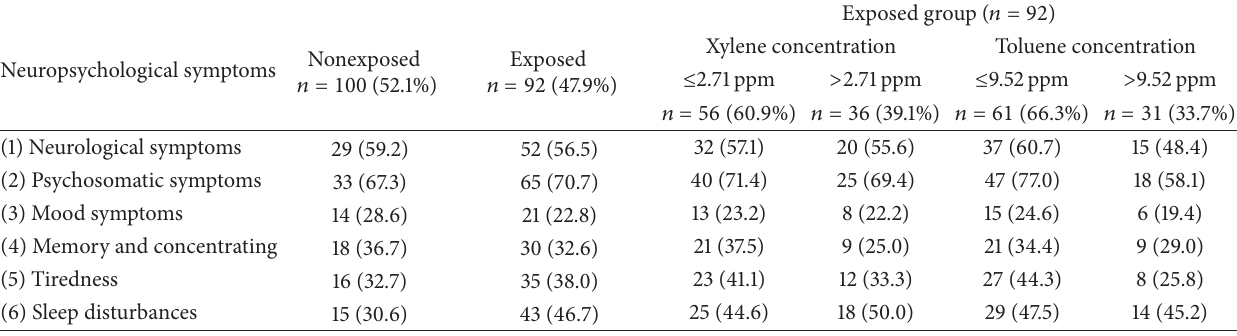
Table 4: Health effects on neuropsychological